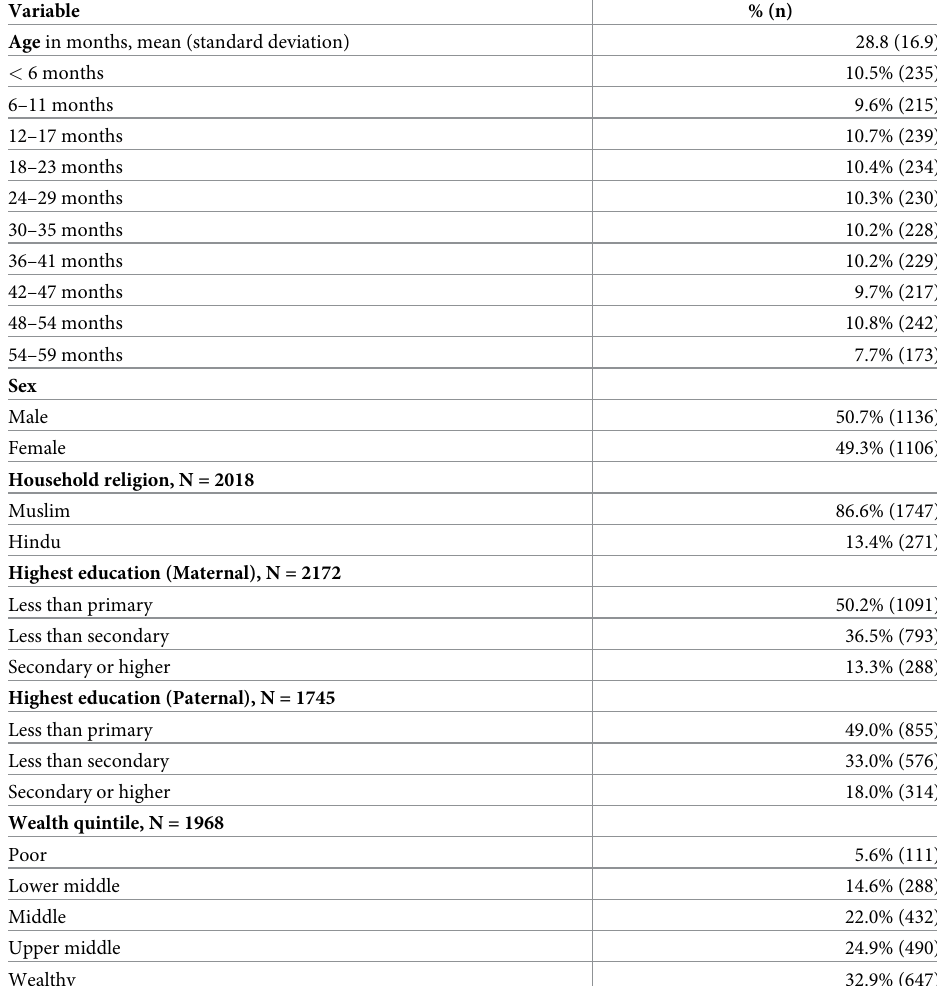
Table 1. Demographic description of the sample, N =